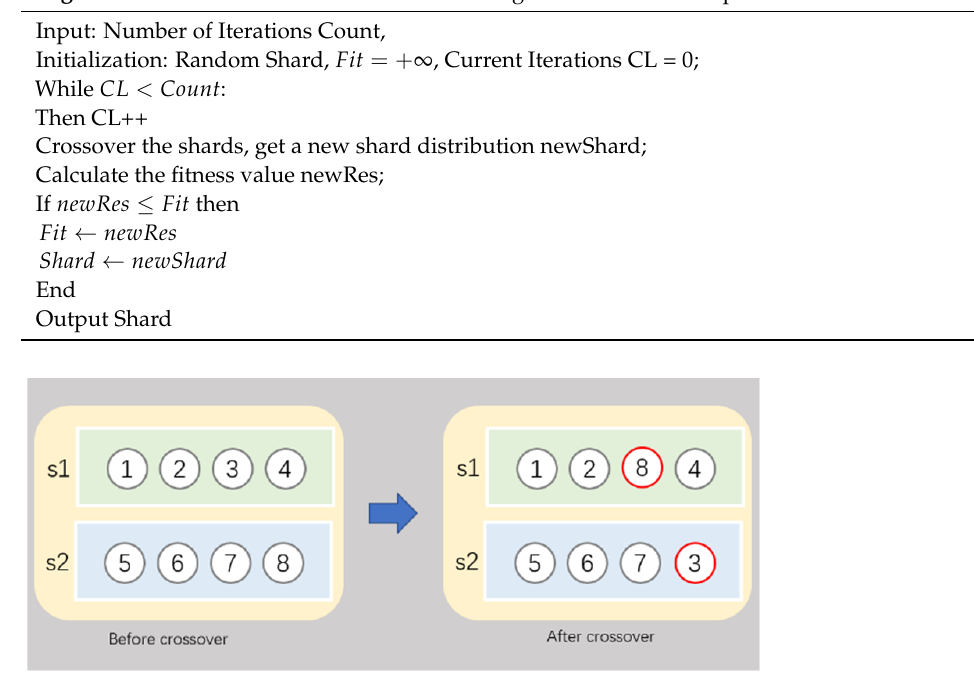
Figure 4. Schematic diagram of node crossing between patches.